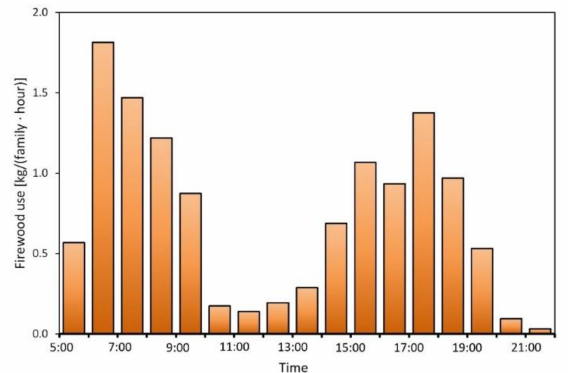
Figure 7. Average hourly firewood consumption pattern of investigated 16 households.